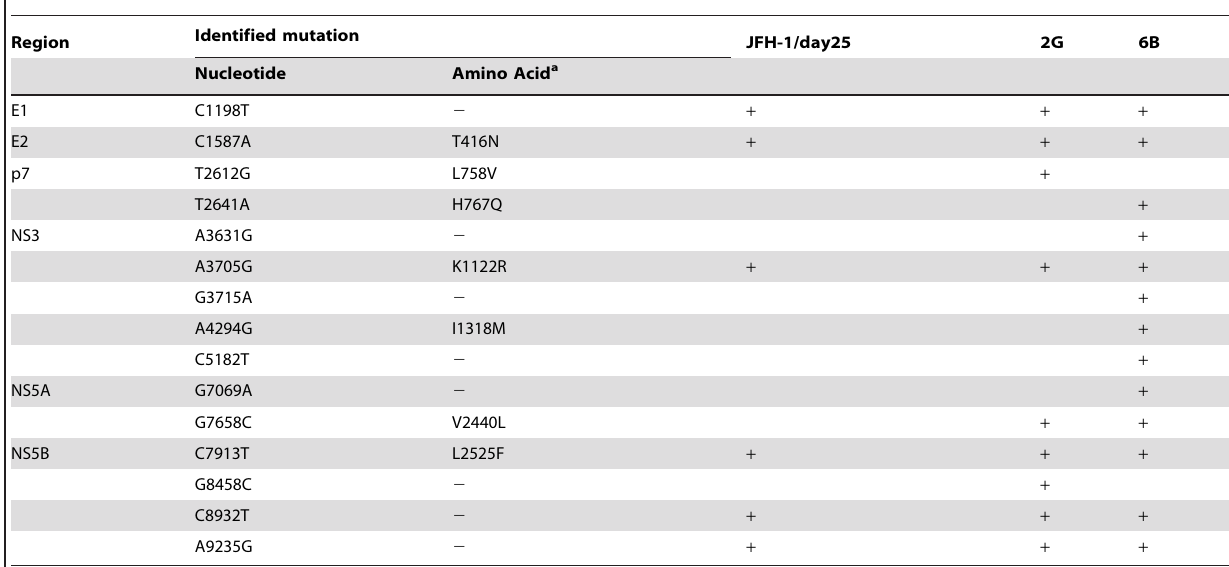
Table 1. Mutations Detected in Cell Culture-adapted JFH-1 Variants.